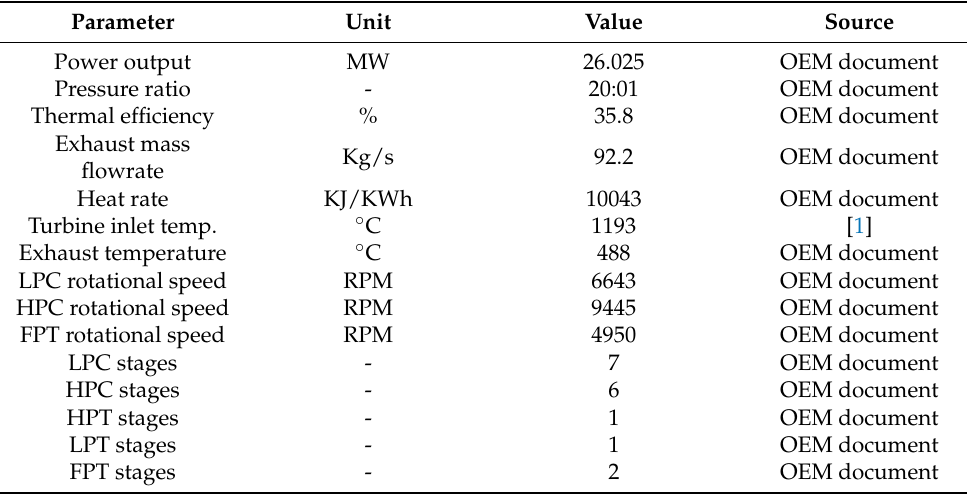
Table 2. Parameters used as